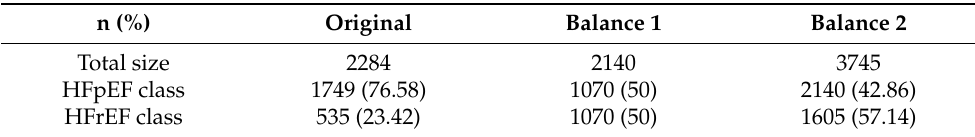
Table 2. Proportion of HFpEF and HFrEF phenotypes in the original dataset and in the two balanced datasets created with SMOTE . n (%) Original Balance 1